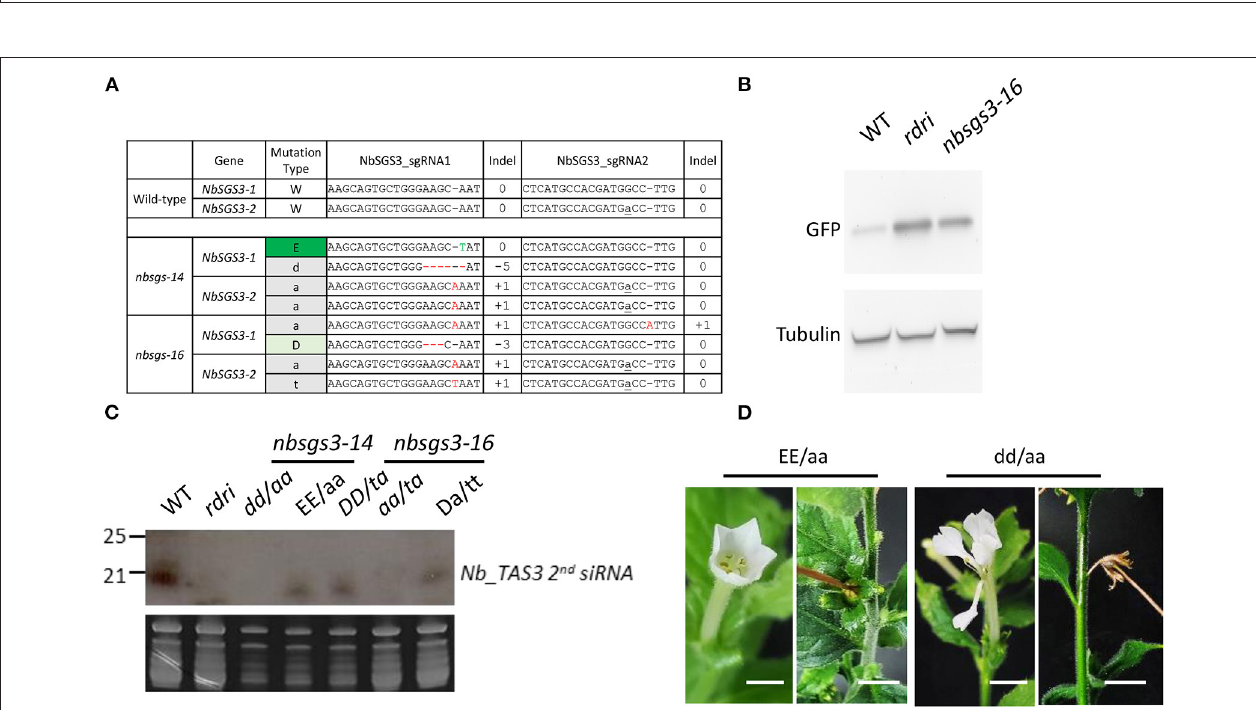
FIGURE 4 | Mutants regenerated from CRISPR-Cas-edited Nicotiana benthamiana protoplasts. (A) Genotypes of F 1 N. benthamiana sgs3 mutants used for small RNA analysis. NbSGS3-1 : Niben101Scf03392Ctg069; NbSGS3-2 : Niben101Scf05468Ctg070. Red -: deleted nucleotide. Letter in gray: inserted nucleotide. Letter in green: edited nucleotide. (B) Five-week-old N. benthamiana plants subjected to Agrobacterium-mediated transient infiltration with 1 OD Agrobacterium cultures (OD 600 = 1) harboring binary vector with Green fluorescence protein ( GFP ) driven by the cauliflower mosaic virus 35S promoter. Leaves were harvested 3 d after infiltration. GFP and tubulin levels were analyzed by immunoblot analysis. (C) RNA gel blot analysis of the progeny of the Nbsgs mutants. WT, wild type; rdri , RNAi line of NbRDR6 ; D , 3-bp deletion. T insertion. (D) The progeny of Nbsgs3-14 . Uppercase letters: in frame; lowercase letters: out of frame. E : base editing. a : A insertion. d : 5-bp deletion. Bar = 5 mm.